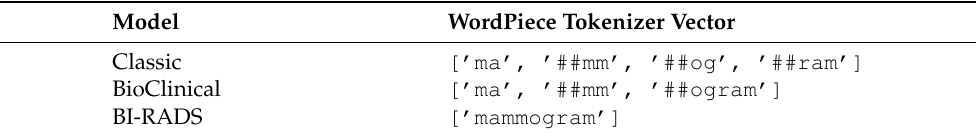
Table 6. Example of WordPiece tokenizer results for the word "mammogram"